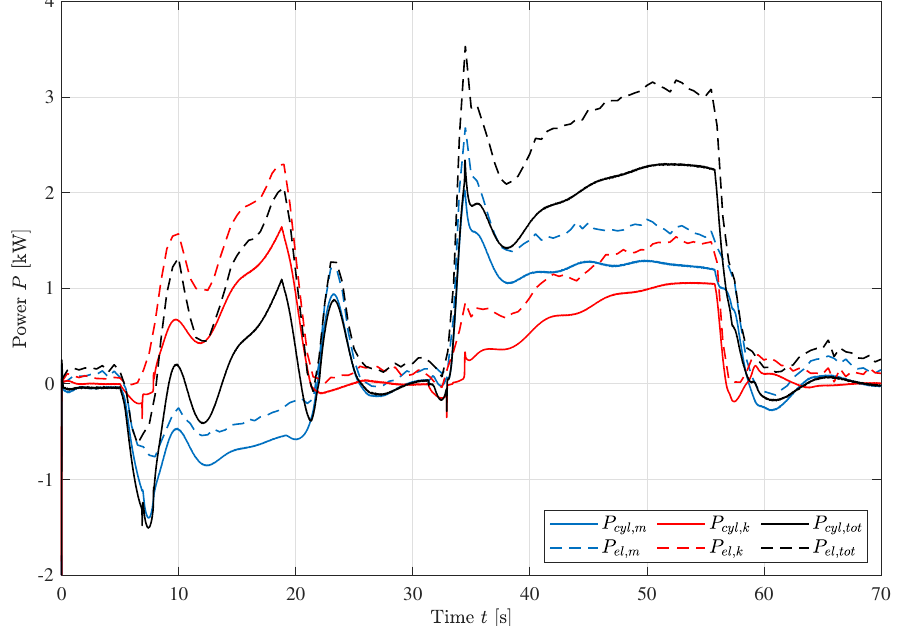
Figure 33. Power from the grid (dashed) and power to the cylinders (solid) with EHAs. A plot of the consumed energy is shown in Figure 34. After completing the motion 47 kJ was delivered to the cylinders while 88 kJ was consumed from the grid. Cylinder position error and swing angle are shown in Figure 35 to verify the perfor- mance of the novel concept. The RMS value of the position errors and swing angle are calculated to be RMS( e m ) = 5.4 mm, RMS( e k ) = 3.3 mm, and RMS( θ p ) = 4.4 mrad, virtually identical to the valve-controlled